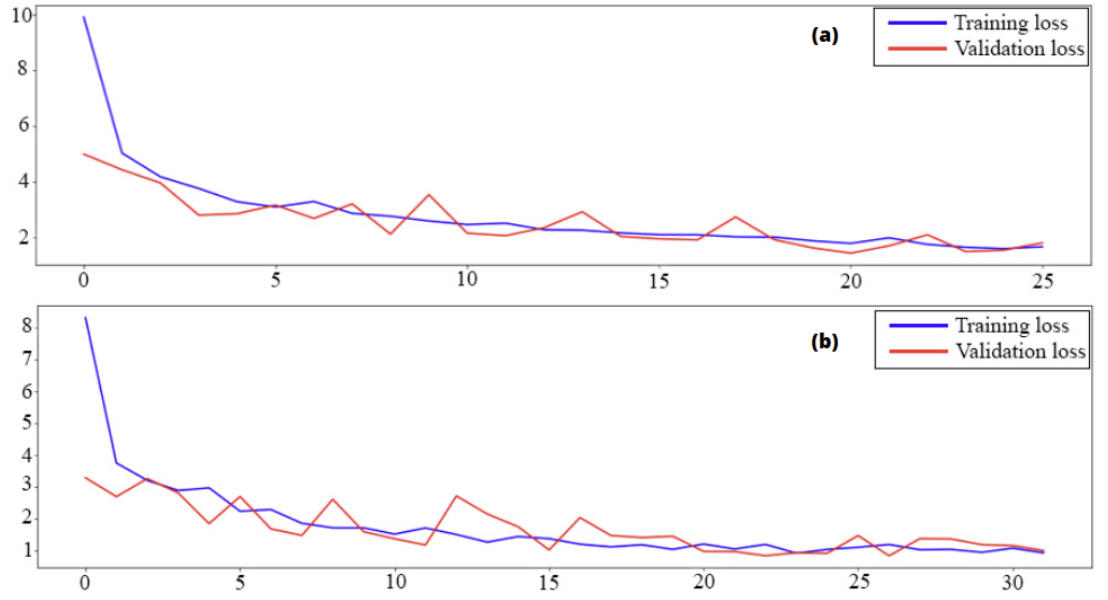
Figure 9. Mean Absolute Percentage Error curves using training and validation data consists in following the evolution of the training according to the number of epochs, ( a ) presents scenario 4 while ( b ) presents scenario